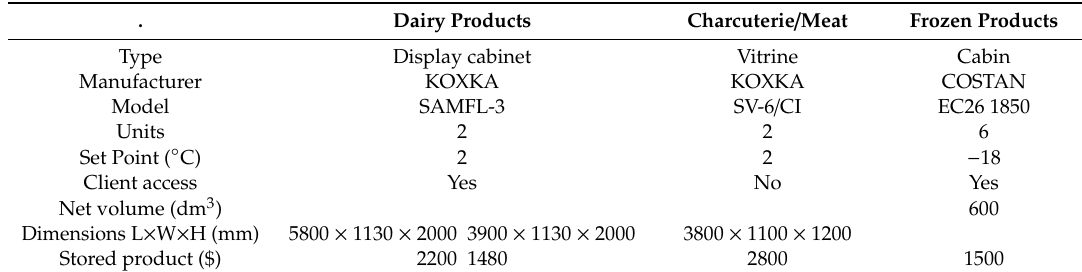
Table 6. Refrigerated cabinets in the pilot shop.